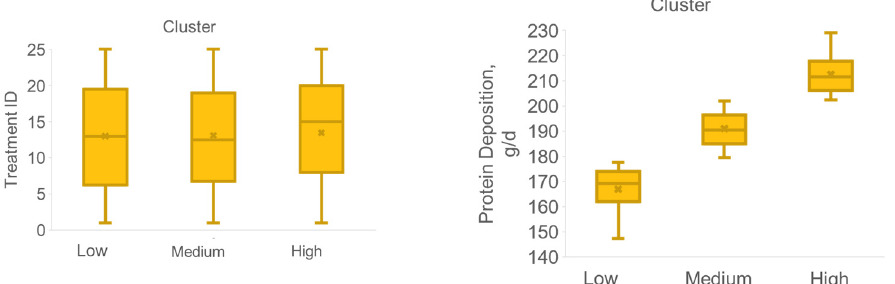
Figure 3. Cluster analysis discriminated pigs with low (167 g/d, n = 16), medium (191 g/d, n = 38), amino acid intake. and high (213 g/d, n = 37) protein deposition, presenting no difference in treatment distribution or amino acid intake.